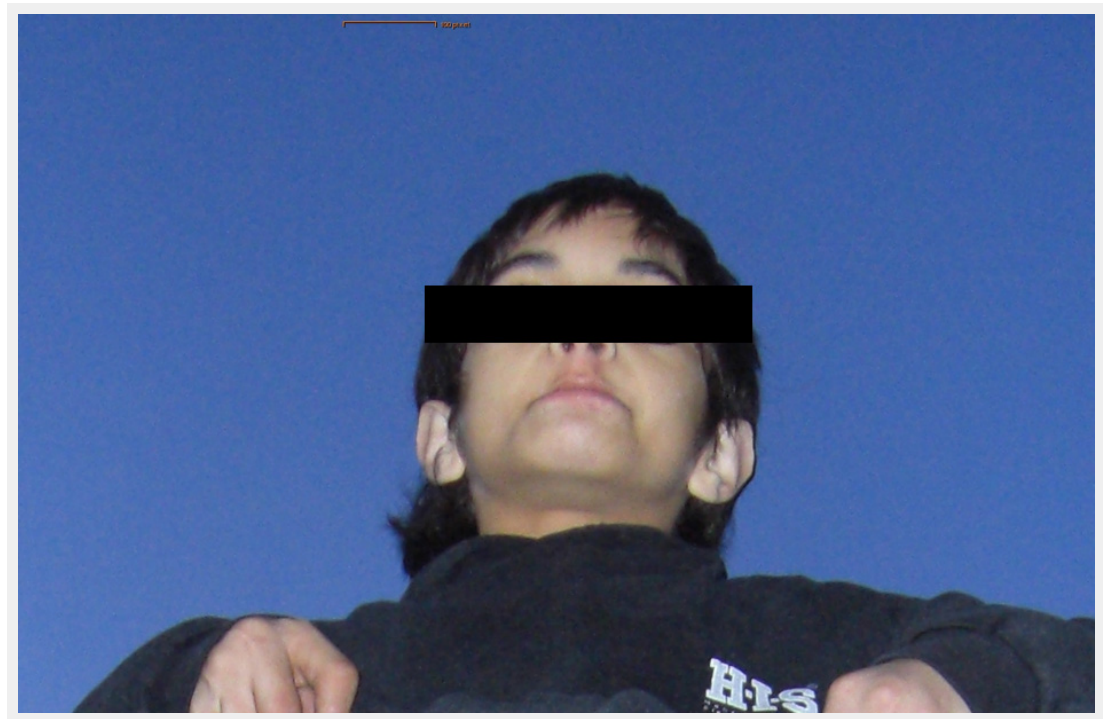
Figure 2 Dysmorphic facial features, bilateral congenital cataract, blepharophimosis with stiff facial muscles and an expressionless dull face are notable. Trismus is also present (spasm around the mouth making it difficult to open on command), and the mouth is involuntary held in a fixed half- smile. (The patient has given written informed consent for